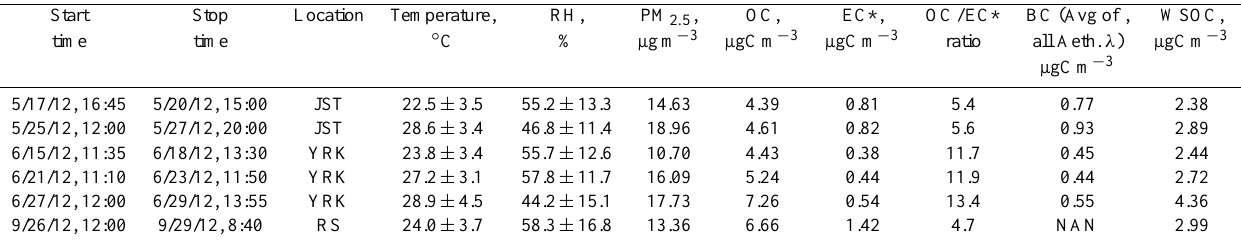
Table 1. Mean and standard deviation of parameters measured with online instruments (except for EC) during MOUDI sampling periods at various sites.